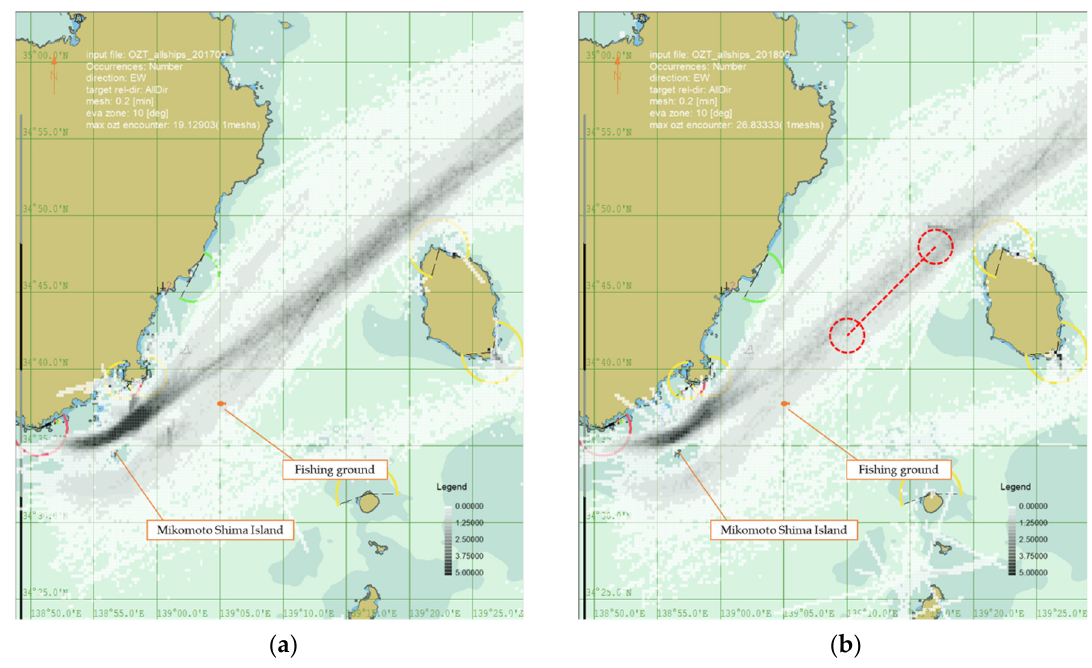
Figure 15. Distribution map of occurrences of the dangerous OZT: ( a ) before the implementation (March 2017) and ( b ) 8 months after the implementation (September 2018). (Sources: AIS data from